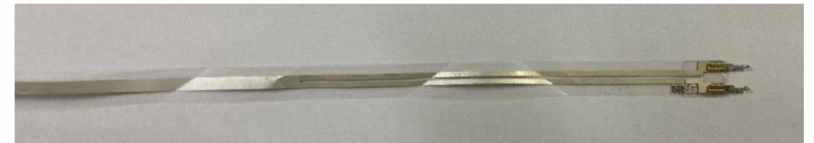
Figure 2. Physical picture of PVDF